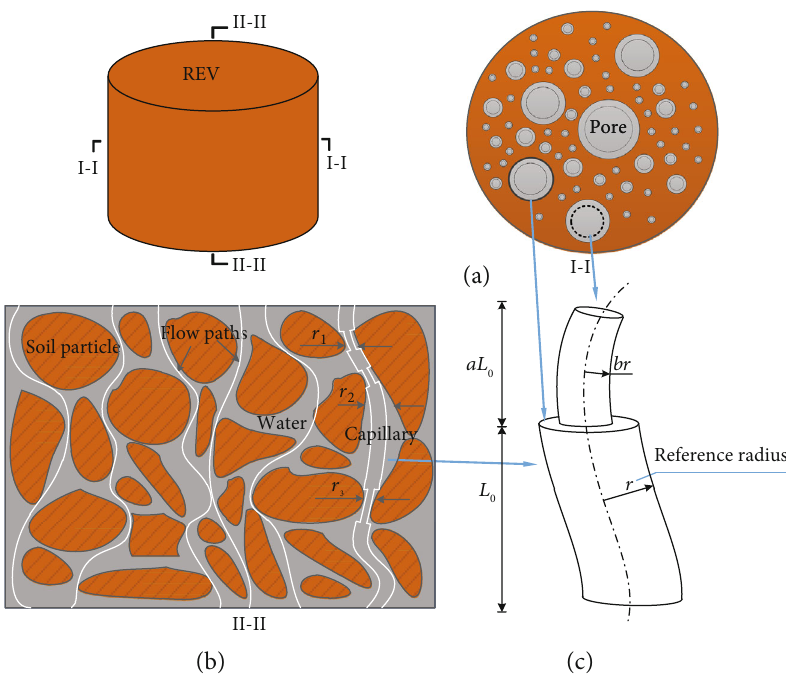
Figure 1: A representative elementary volume (REV). (a) The reference cross section of the REV fi lled by reference radii. (b) The pore space and fl ow paths in the REV. (c) The simpli fi ed capillary containing two di ff erent cross-sectional